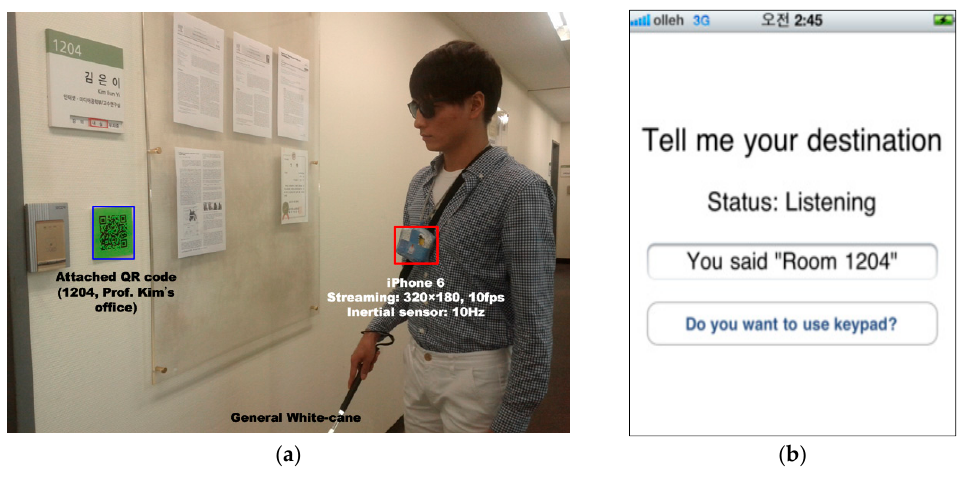
Figure 16. A user performing the initial tasks: ( a ) A user is moving according to the guidance by the